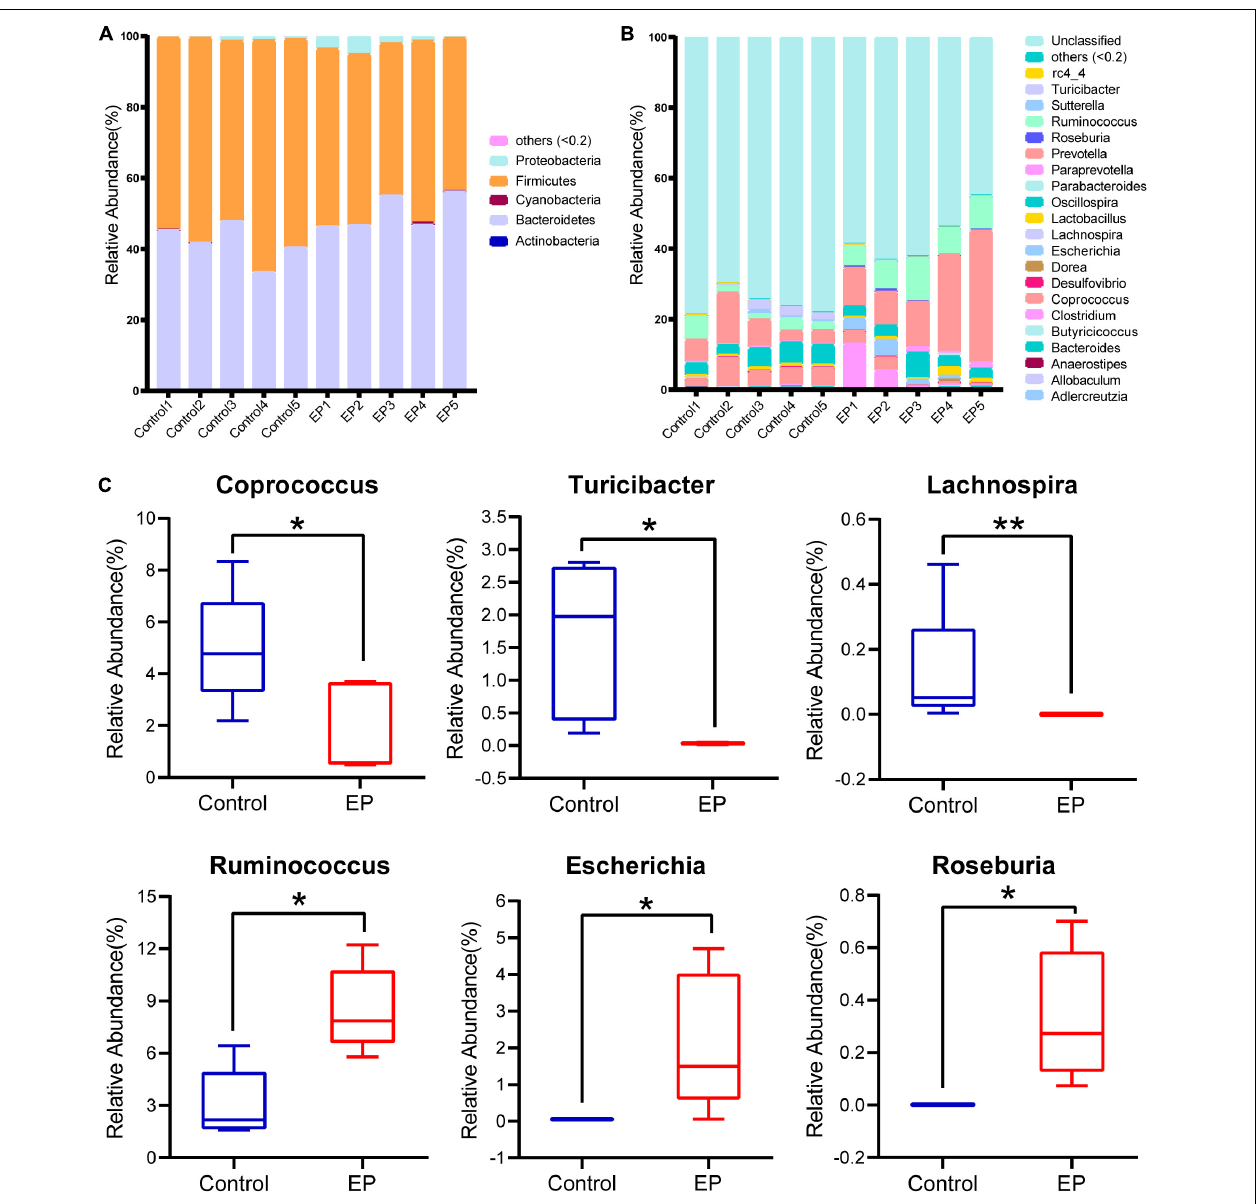
FIGURE 2 | Differences in gut microbiota profile between EP and Control. Relative abundance of fecal microbiota composition at the level of phylum (A) and genus (B) of fecal samples in EP and Control. (C) Significantly different gut microbiota at genus level in EP compared with Control. * p < 0.05 and ** p < 0.01. EP, experimental periodontitis group; Control, healthy control